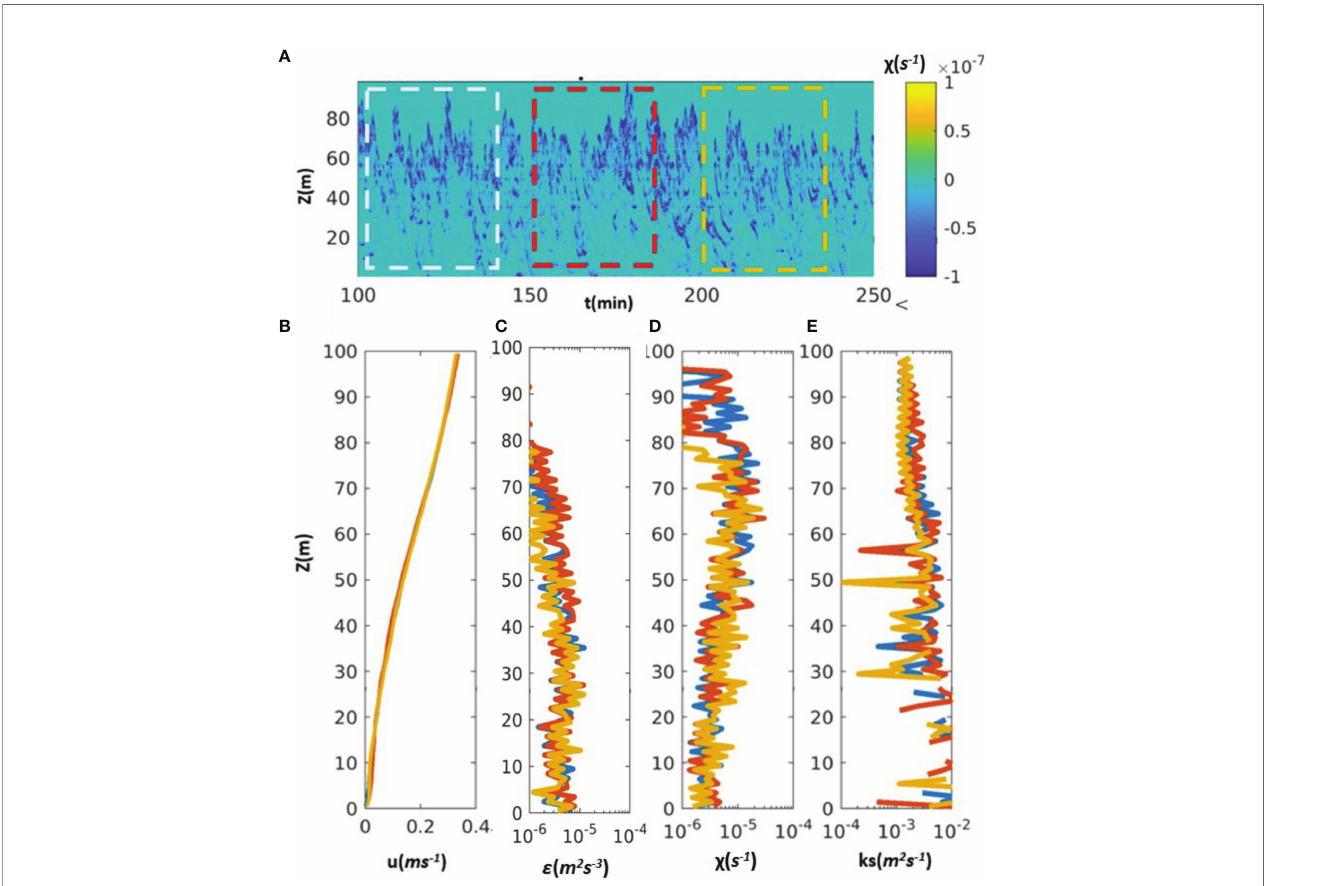
FIGURE 11 | Model results of Case B: the time series of (A) density variance dissipation. The blue, red, and orange lines indicate the interval for 30 minutes time average. (B) The time average pro fi les of fl ow shear, (C) TKE dissipation rate, (D) density variance dissipation, and (E, C) eddy diffusivity at location x=800 m (see Figure 4 for the